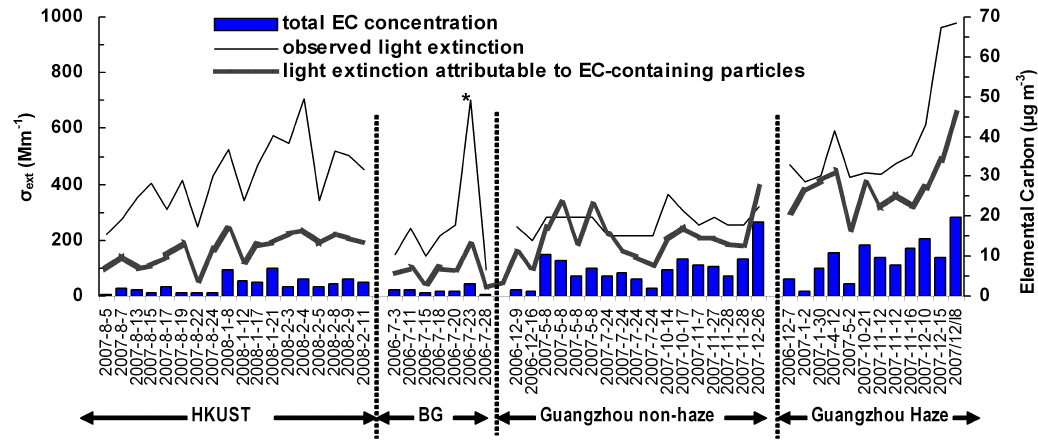
Fig. 4. Calculated and observed light extinction coefficients at the selected urban, suburban and rural locations in the Pearl River Delta region. An episodic biomass burning event occurred nearby the rural sampling site on the sampling day marked with